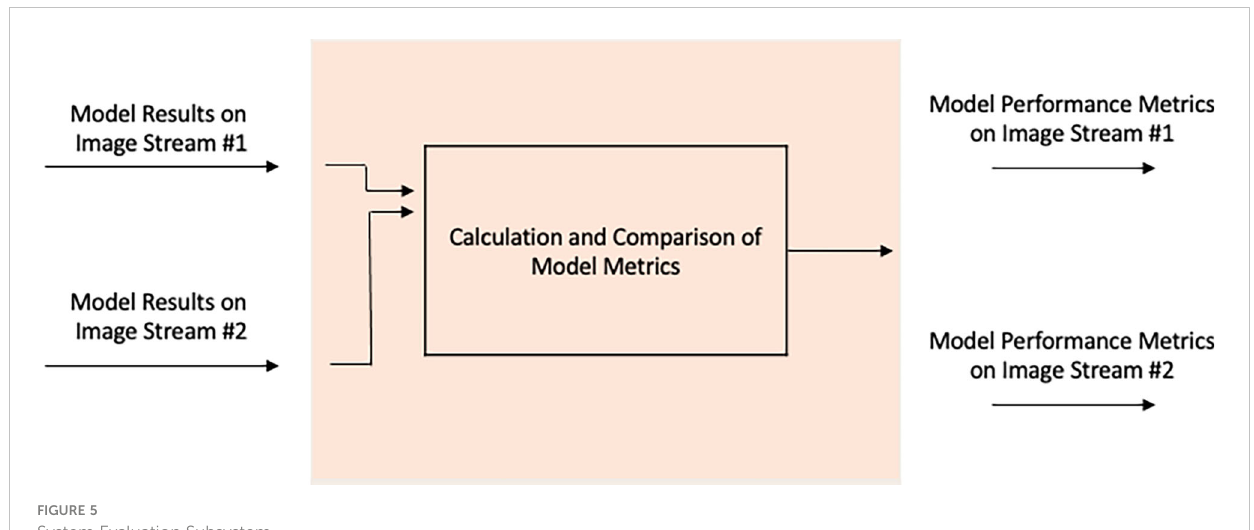
FIGURE 5 System Evaluation Subsystem.